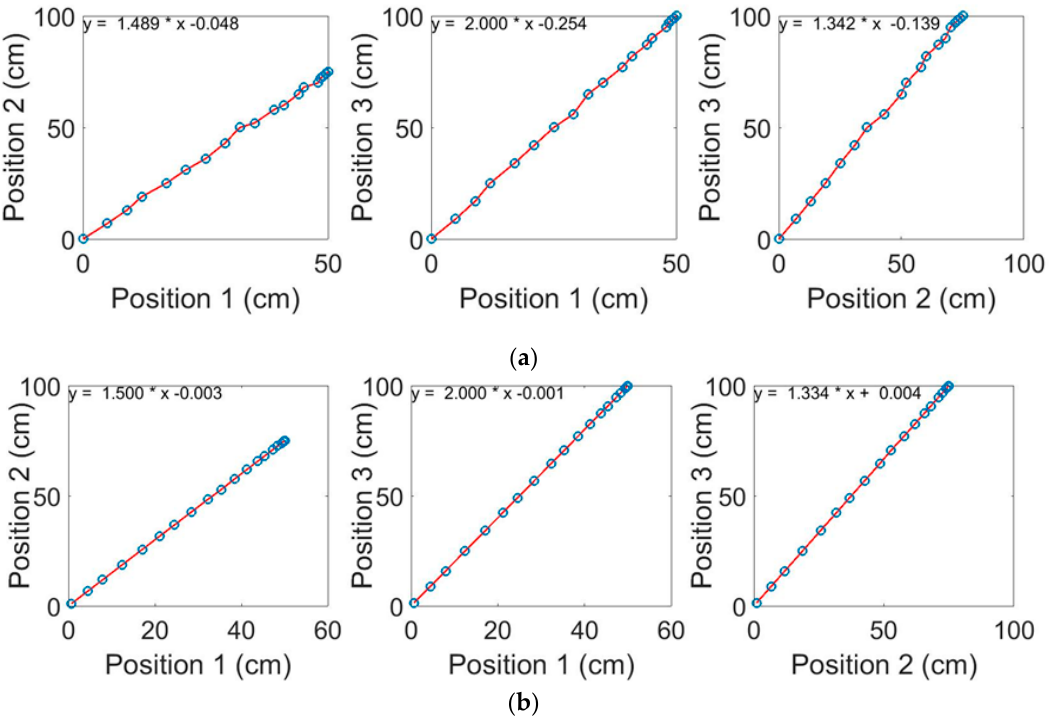
Figure 7. Analysis of the three positions ( a ) manual and ( b ) accelerometry.